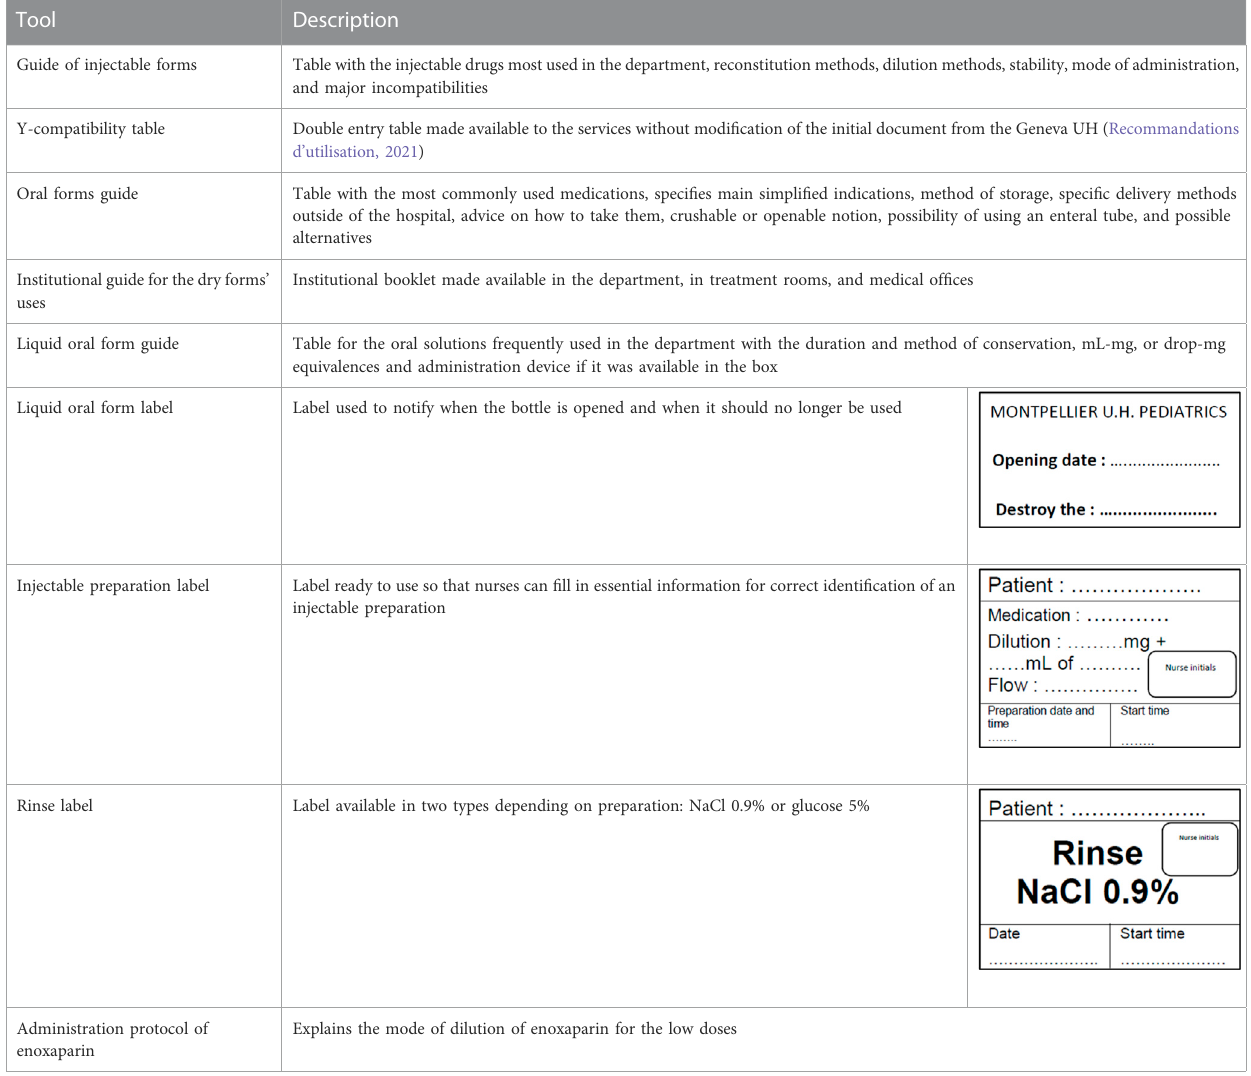
TABLE 5 PUM tools